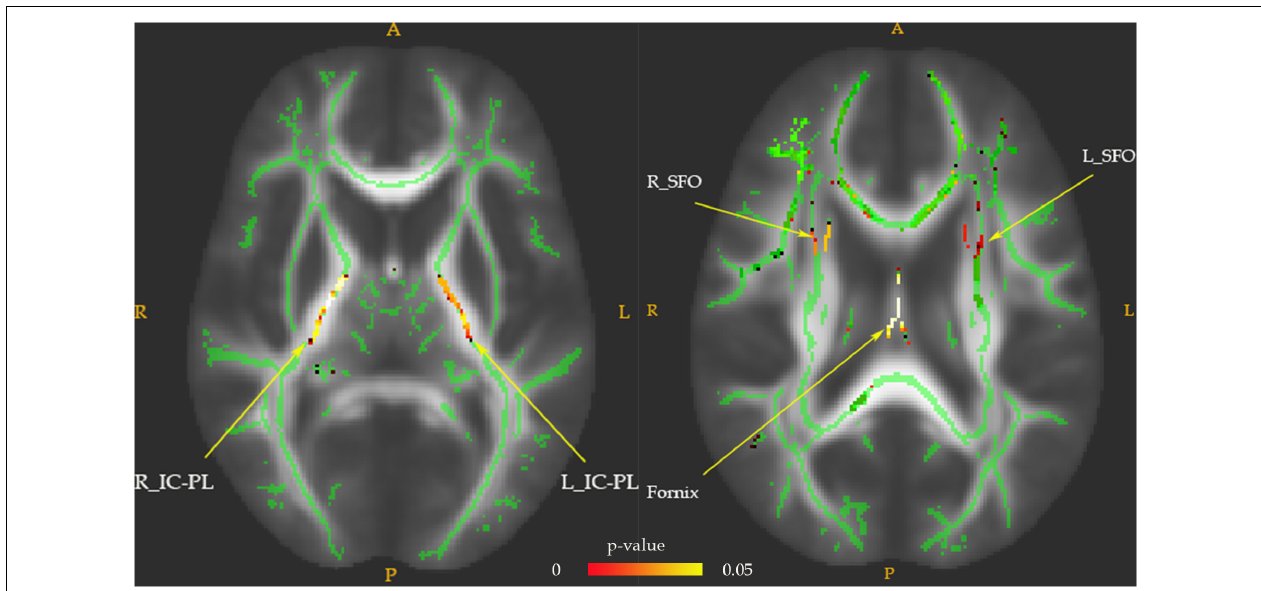
FIGURE 1 | The FA values comparison between pretreatment MDD and HC groups. Lower FA in MDD patients ( n = 28) vs. HC ( n = 25) in the fornix tract, bilateral superior fronto-occipital fasciculus (SFO), and bilateral posterior limb of the internal capsule (IC-PL). The white matter FA values of MDD patients were significantly lower than that of the control group in axial slices, as demonstrated in red-green (FWE-corrected p < 0.05, cluster > 20).